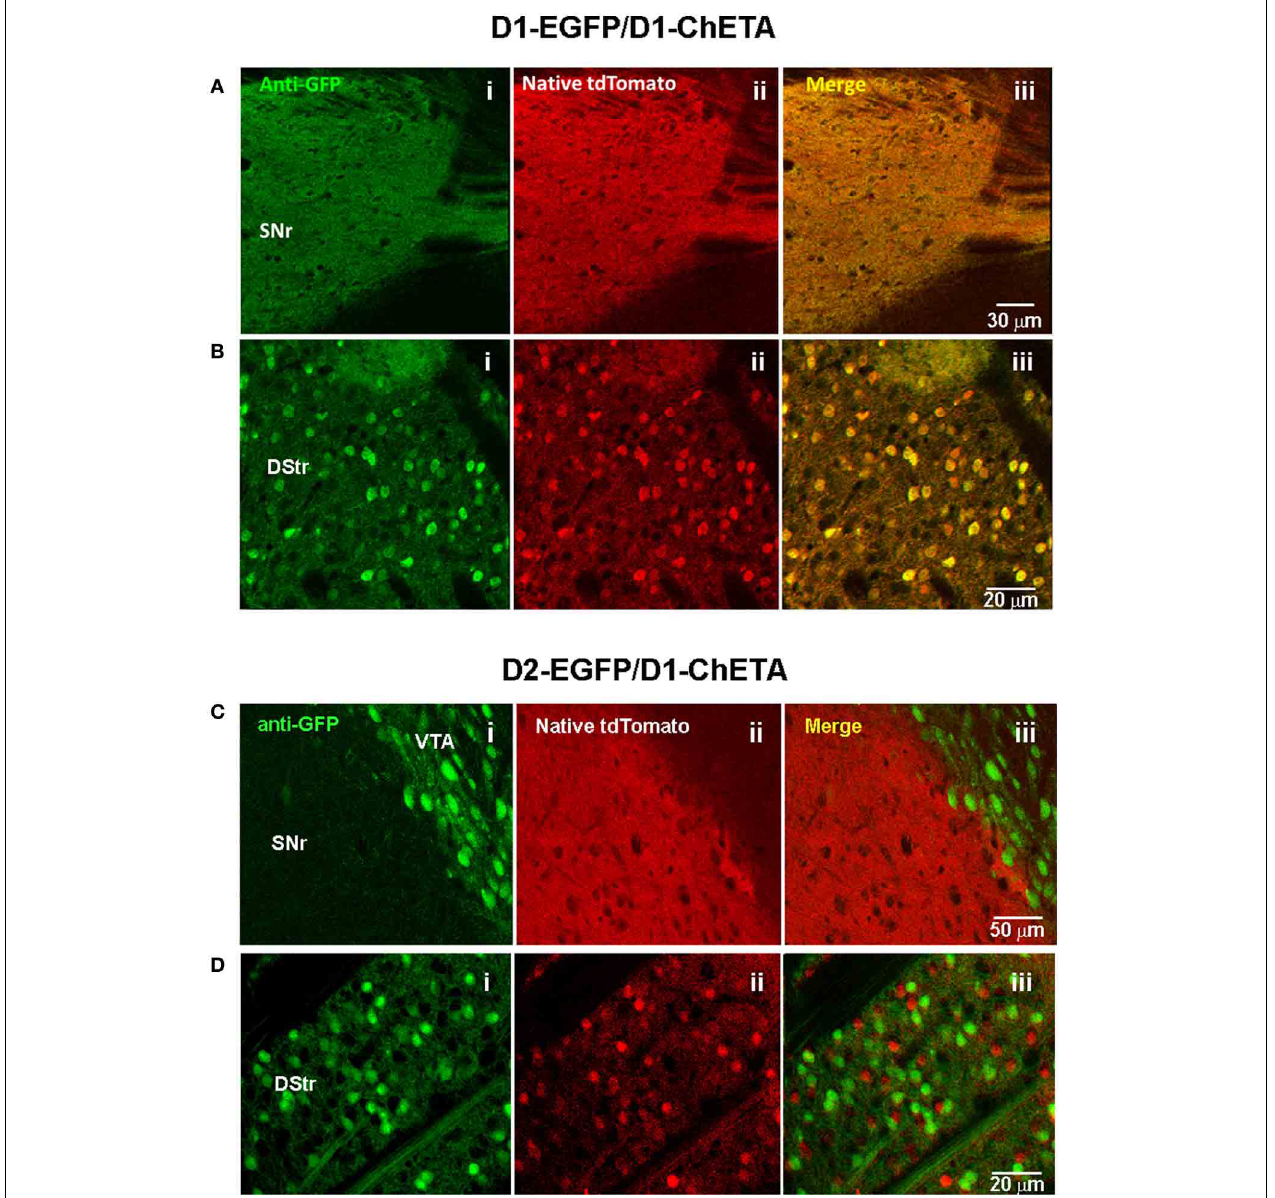
FIGURE 6 | Validation of transgene expression in striatonigral but not striatopallidal MSNs in D1-ChETA line 1 mice. (A,B) Confocal images in brain slices from D1-EGFP/Drd1a-ChETA double transgenic mice. (A) Substantia nigra pars reticulata (SNr) region showing anti-EGFP (Ai) , native tdTomato fluorescence (Aii) , and the merged